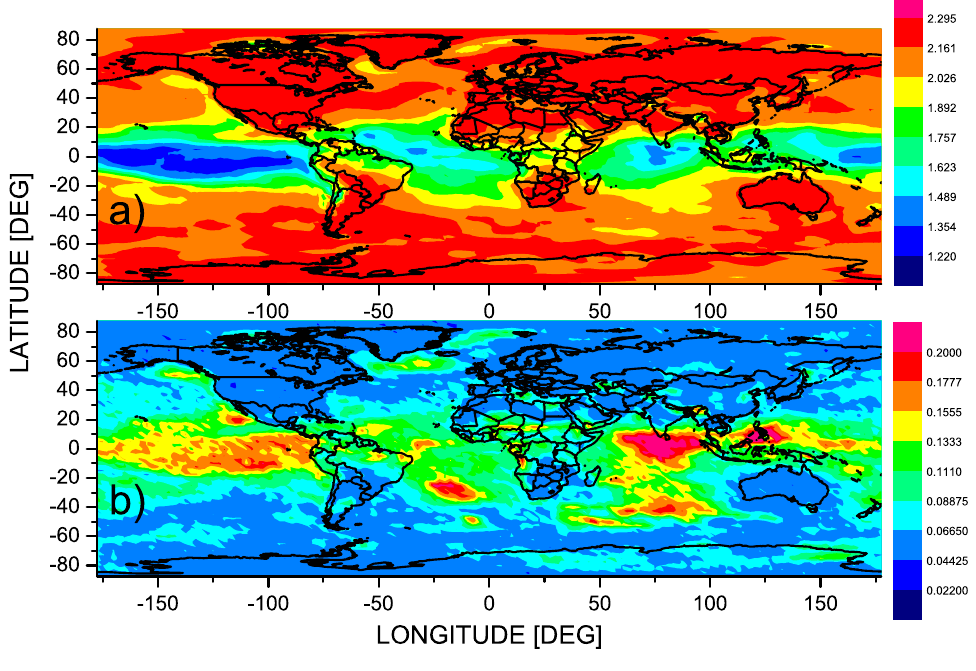
Fig. 5. SATA signal complexity measured by the Gaussian process entropy rate h G (a) . Mean absolute correlations of SATA with their independent univariate FT surrogate data (b) .